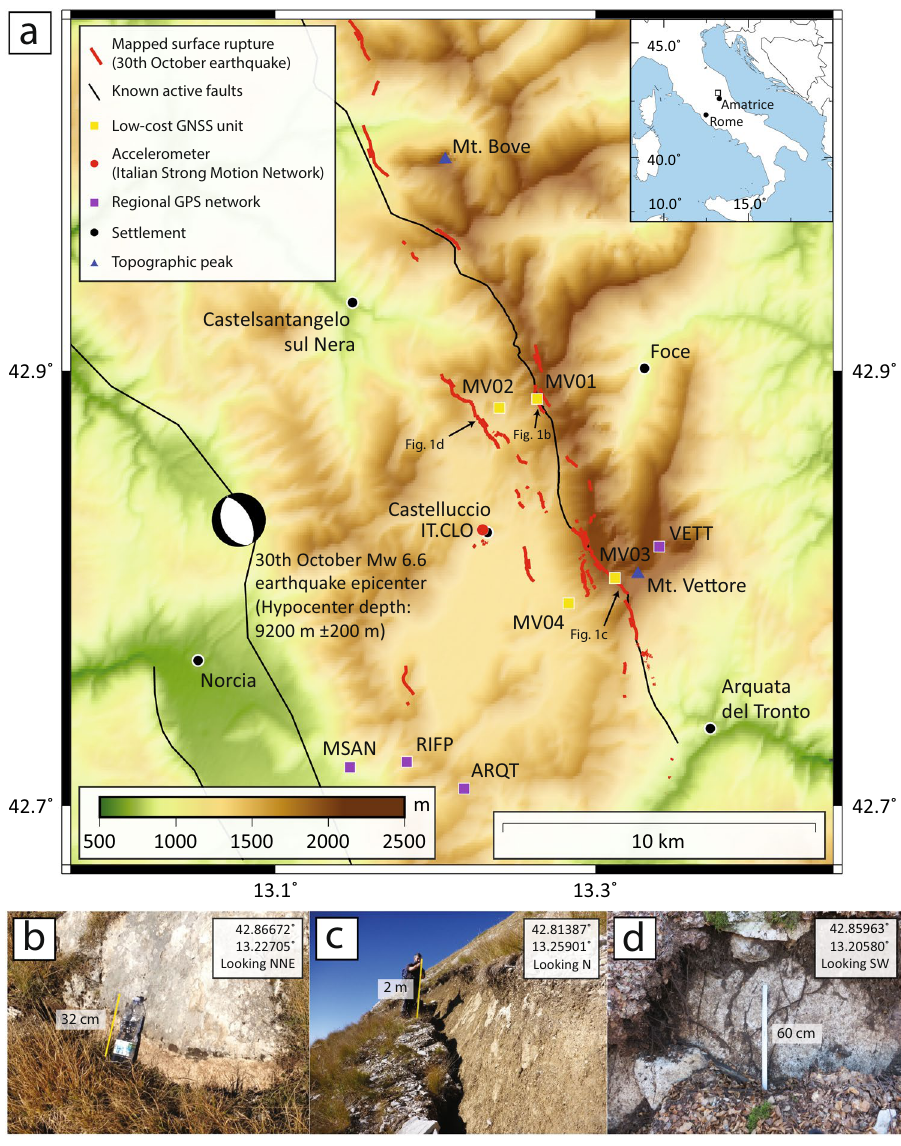
Figure 1. ( a ) Location map of 6.6 Mw October 30th Vettore earthquake. Red lines are surface ruptures from this event mapped by the EMERGEO working group using ground observations. MV01, MV02, MV03 and MV04 are GNSS units used in this study. Additional GNSS stations operated by other researchers are: VETT (INGV – IGM network benchmark), ARQT (INGV, RING network), RIFP and MSAN (INGV – CaGeoNet network). IT.CLO is a strong motion station situated near the village of Castelluccio. The location of the earthquake epicentre was retrieved from http://cnt.rm.ingv.it/en/event/8863681 5 . Map coordinates are latitude and longitude decimal degrees of the geographic co-ordinate system WGS84. Topographic elevation is based on 90 m SRTM data 24 . Map generated using GMT software v. 4.5.15 (http://www.soest.hawaii.edu/gmt/) 25 . ( b ) Mt. Vettore fault close to MV01. ( c ) Mt. Vettore fault close to MV03. ( d ) Antithetic fault SW of MV01-MV02